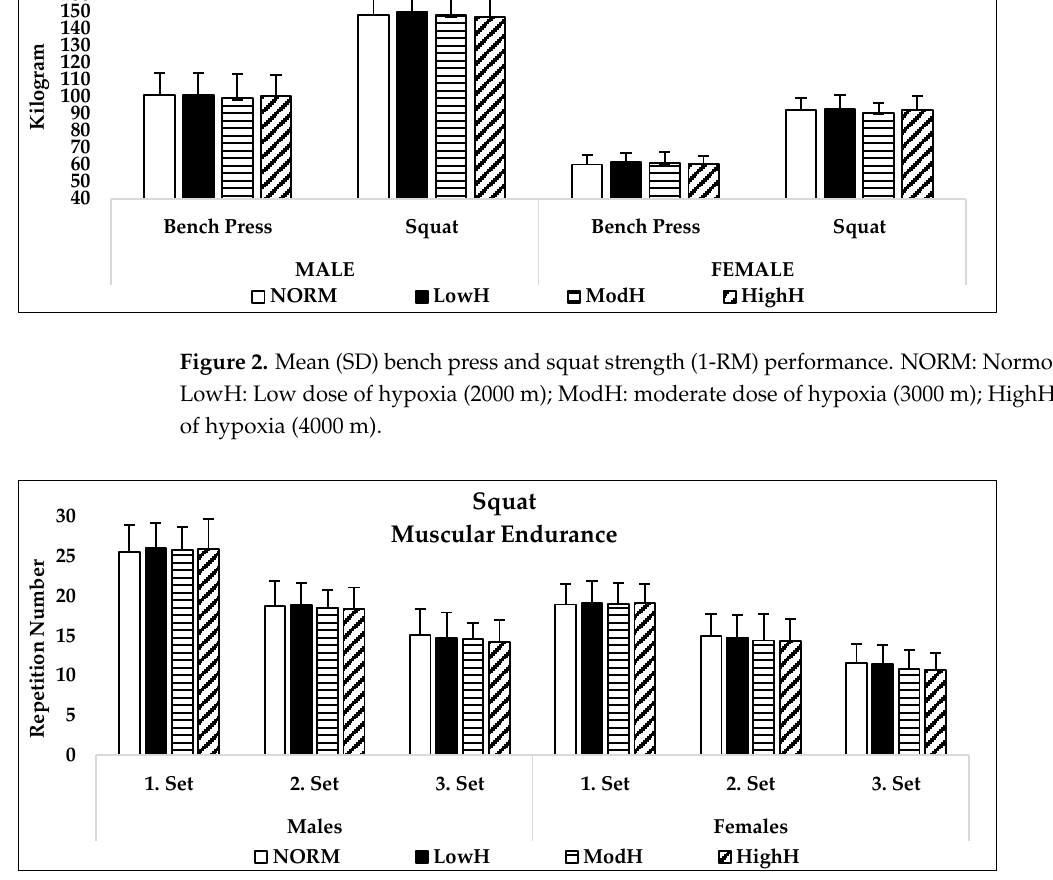
Figure 3. Mean (SD) squat 60% of 1RM endurance performance of males and females. NORM: Normoxia (900 m); LowH: Low dose of hypoxia (2000 m); ModH: moderate dose of hypoxia (3000 m); HighH: high dose of hypoxia (4000 m).